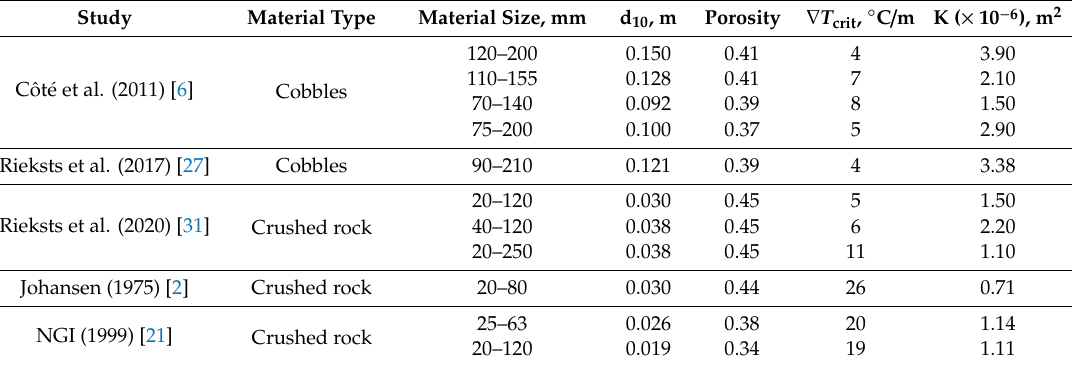
Figure 19. Experimental relationship between heat flux and temperature gradient from studies reviewed (120–200 mm material shown is from Côté et al. (2011) [6]; 25–63 mm material shown is from NGI (1999) [21]). Table 7. Material characteristics and established K values of di ff erent